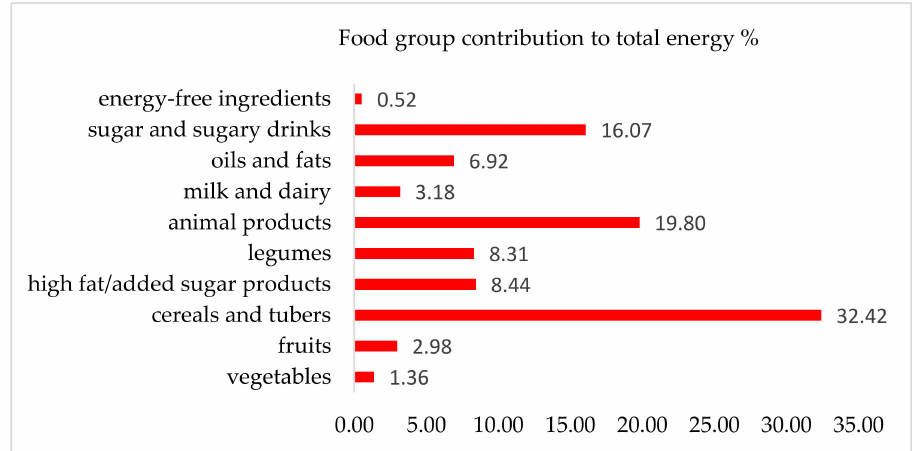
Figure 6. Food group contribution to total dietary energy ( n = 67